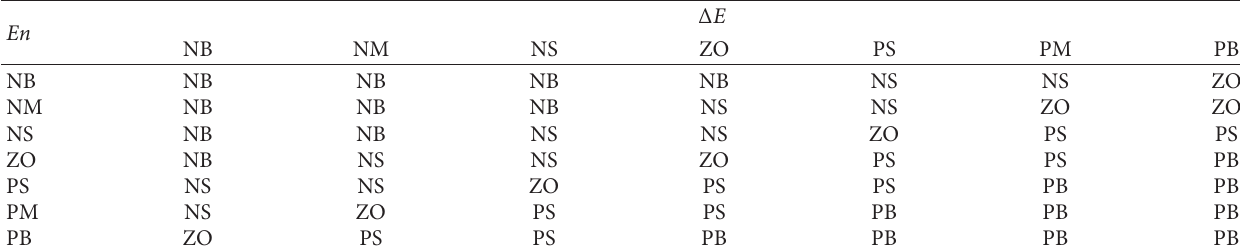
Figure 7: (a) The subordinate function of e . (b) The subordinate function of ec . (c) The subordinate function of D. Table 1: Fuzzy rule inference table.